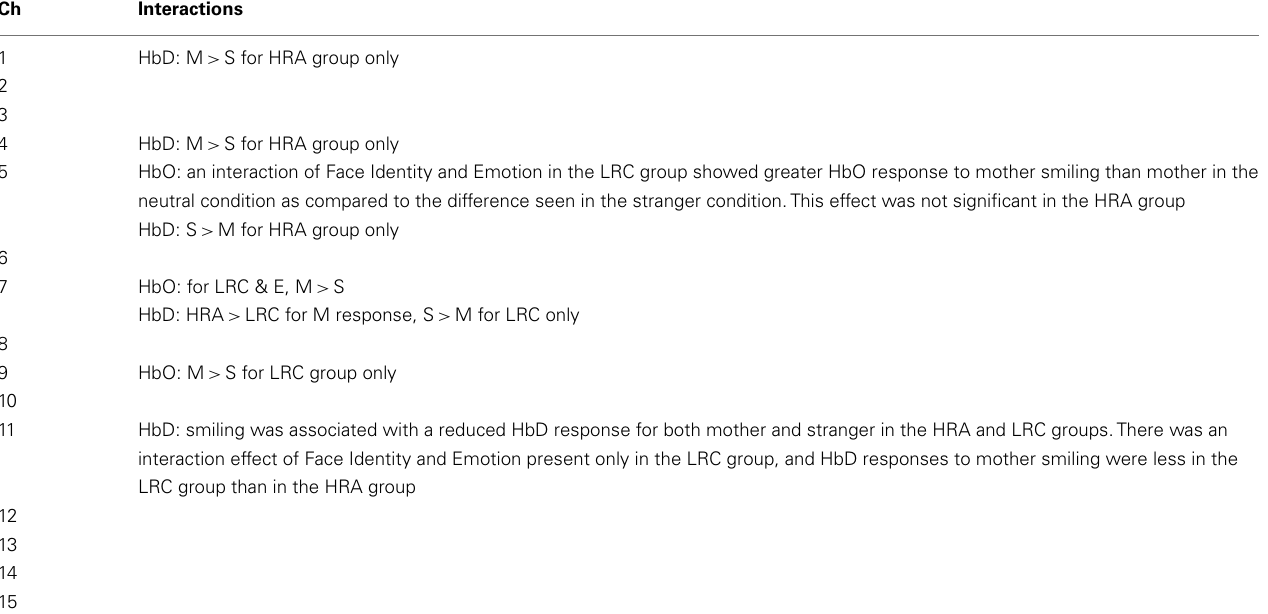
Table 1 | Results of face identity × emotion × groupANOVA by